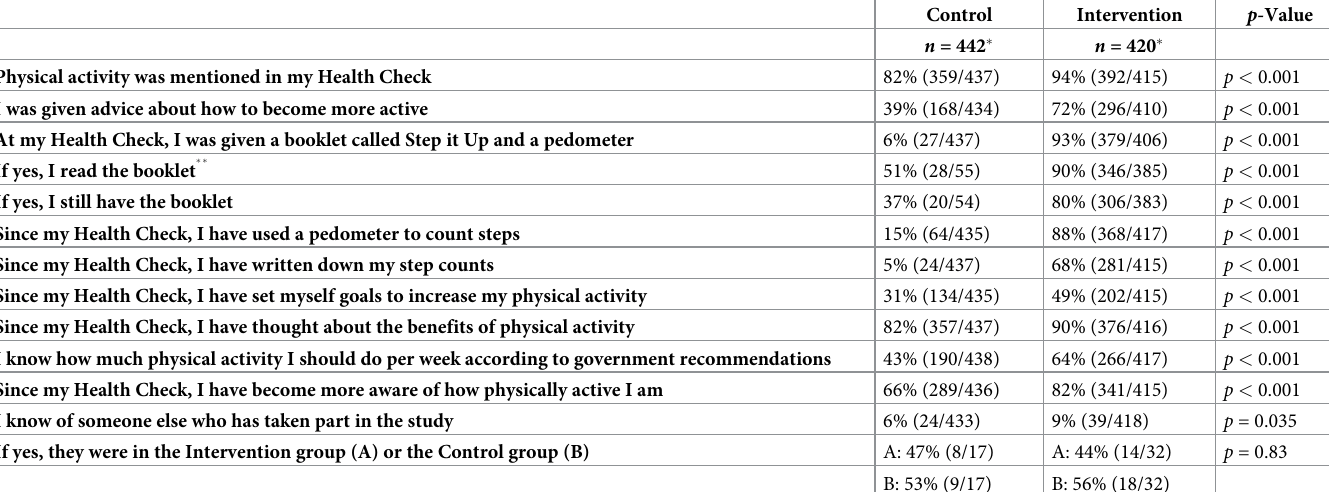
Table 5. Recall of the NHS Health Check, enactment of BCTs, and contamination. Values are percentages (numbers).